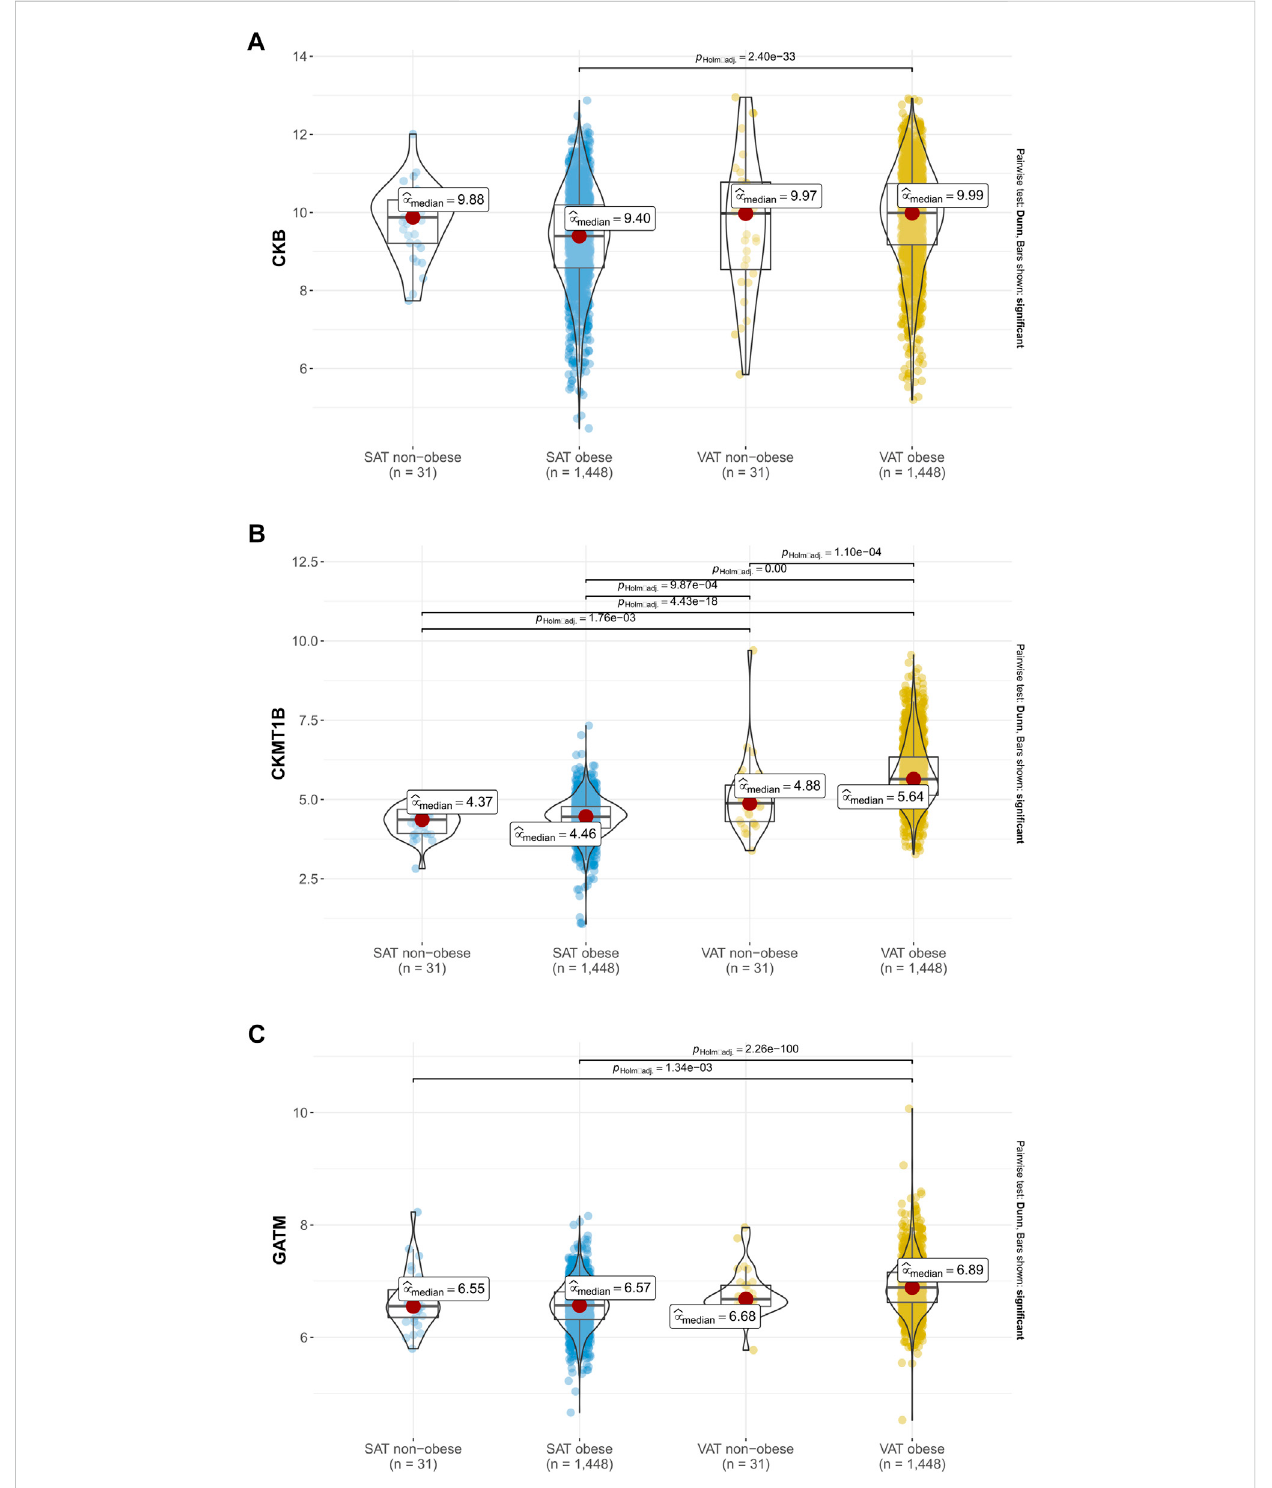
Geneexpressionof CKB , CKMT1B and GATM inprobands with andwithoutobesity. Expression data of CKB (A) , CKMT1B (B) and GATM (C) arebased on 1,479 probands with and without obesity from the LOBB. As the data were not normally distributed in all instances, non-parametric Kruskal –